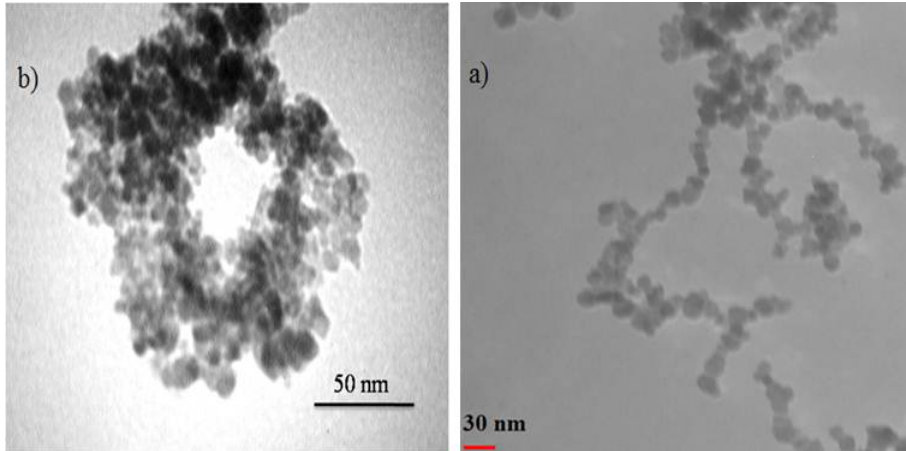
O nanoparticles 3 4 nanoparticles.